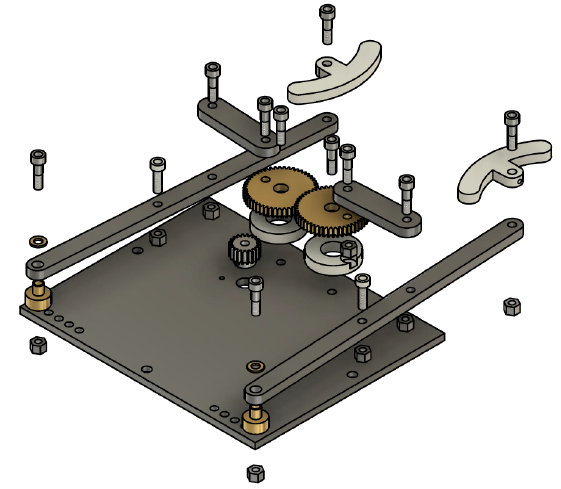
Figure 14. Schematic representation of the assemble. The design will require adjustments.